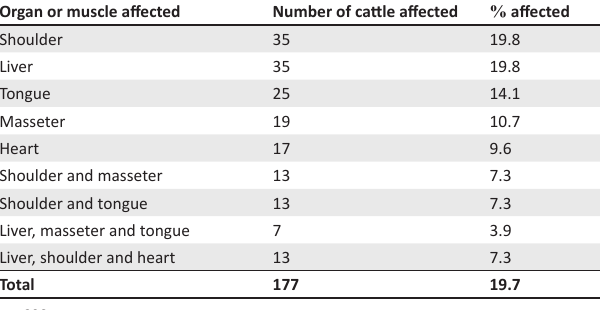
TABLE 1: Prevalence of T aenia saginata cysts in cattle slaughtered in Harar Municipal Abattoir. Organ or muscle affected